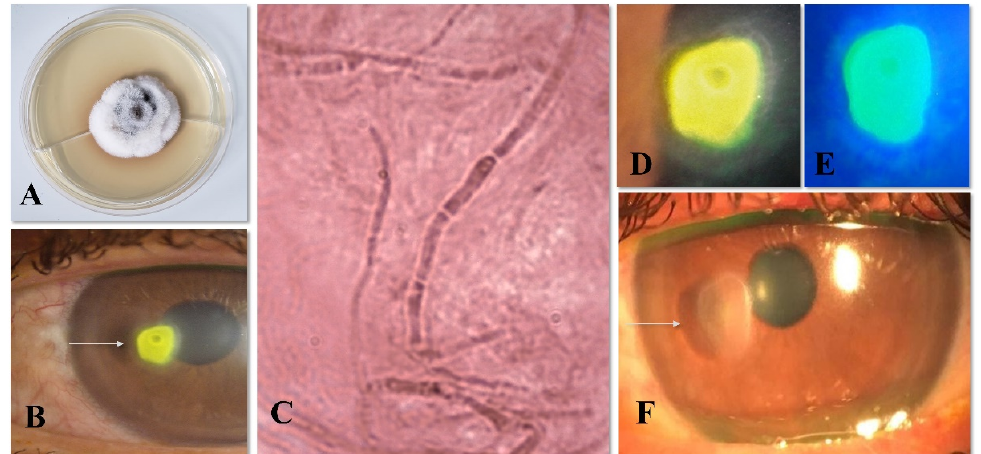
Figure 1. Fungal Infection keratitis clinical signs and causal agent identification ( A ): Roussoella neopustulans macro morphology of the colony; ( C ): direct exam showing septa hyphae by Gram staining (1000× magnification); ( B , D , E ): Nasally located fluorescein ‐ stained corneal ulcer on presentation; ( F ): Superficial nummular scar 3 months after treatment.